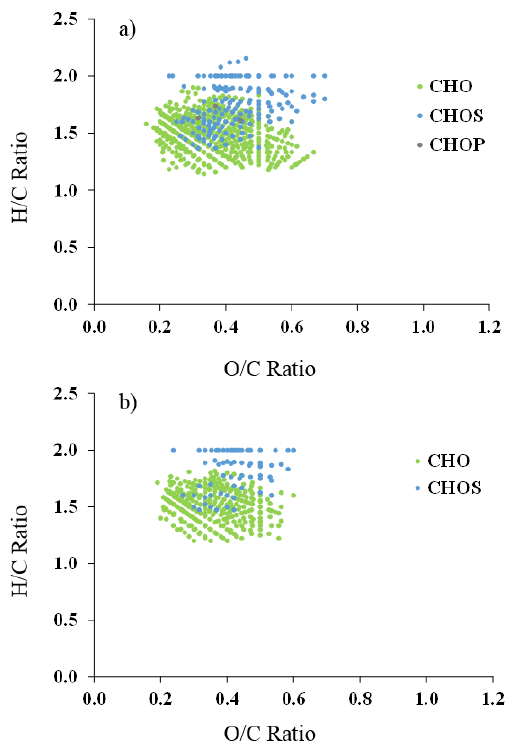
Figure 3. van Krevelen diagrams for aerosol WSOM molecular for- mulas assigned to greater than (a) 75% (at least 18 samples) and (b) 90% (at least 22 samples) of the 24 aerosol samples. Data points are color coded for molecular formula elemental composition as de- scribed in the figure